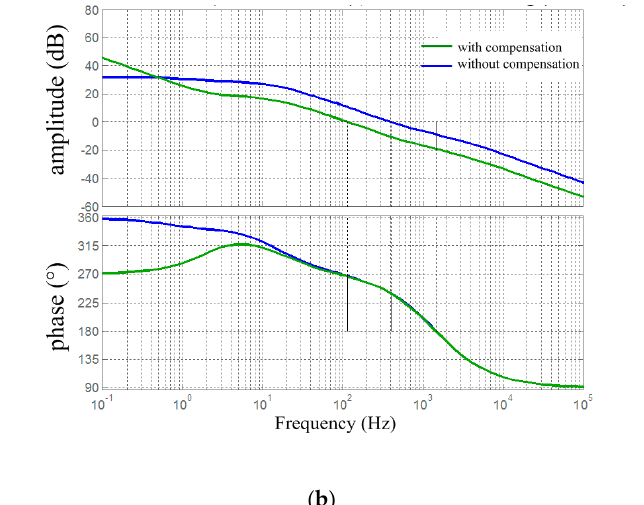
Figure 3. Bode plots for the transfer functions with and without compensation: ( a ) Inductor current; ( b ) DC-link voltage.